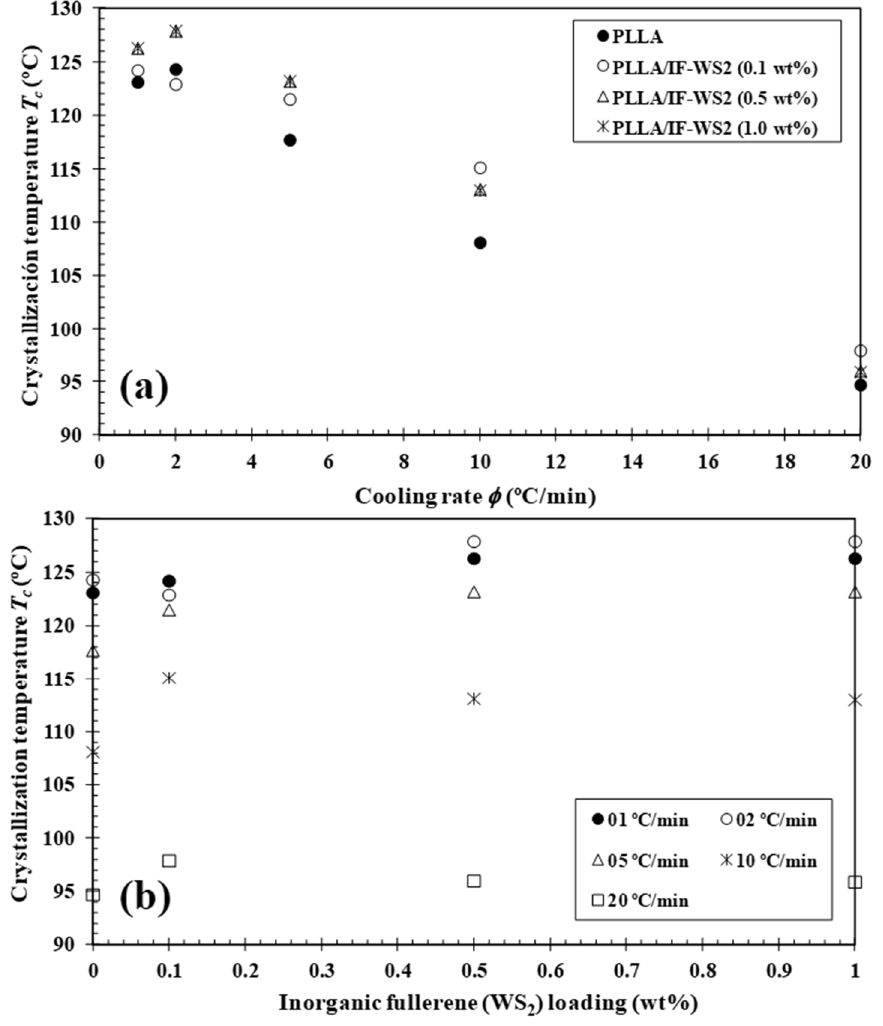
Figure 4. Variation of the melt–crystallization temperature (T c ) for PLLA/IF-WS 2 nanocomposites with ( a ) cooling rate and ( b ) composition.